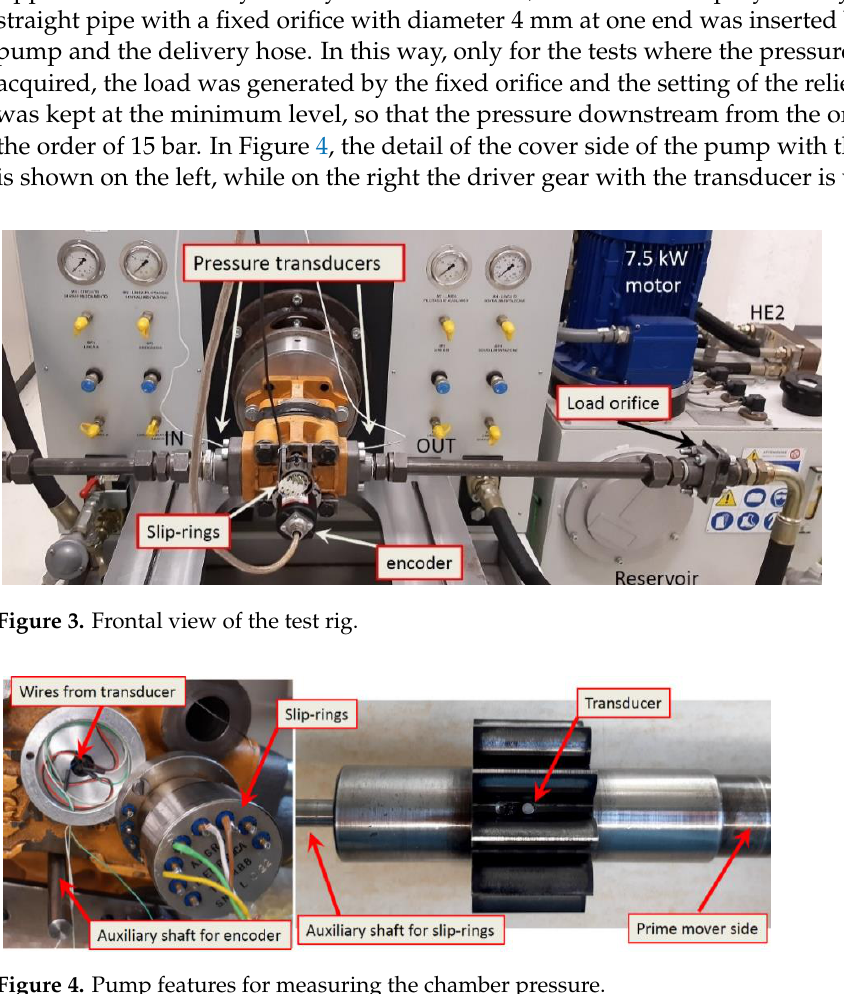
Table 2. Technical data of the pressure transducers mounted directly on the pump.